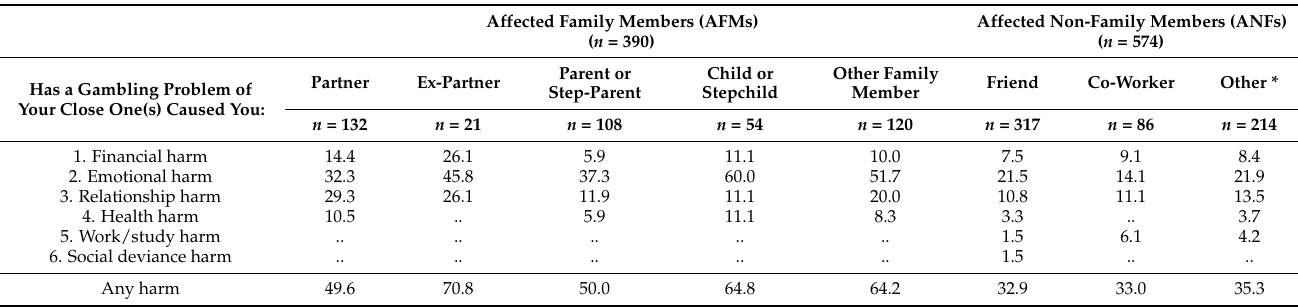
Table 3. The type of gambling harms in 2016 for the AOs by the problem gambler’s relationship to the